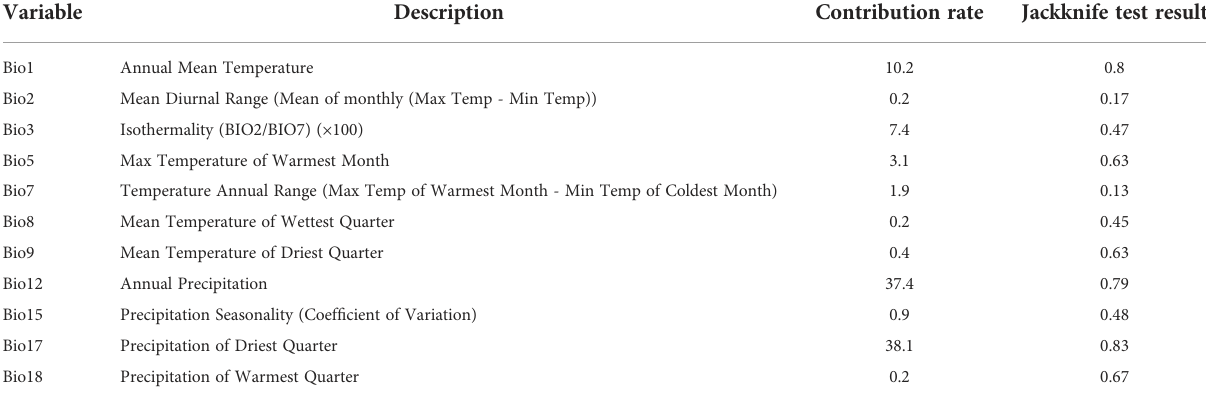
TABLE 2 The description and contribution weight of eleven selected climatic